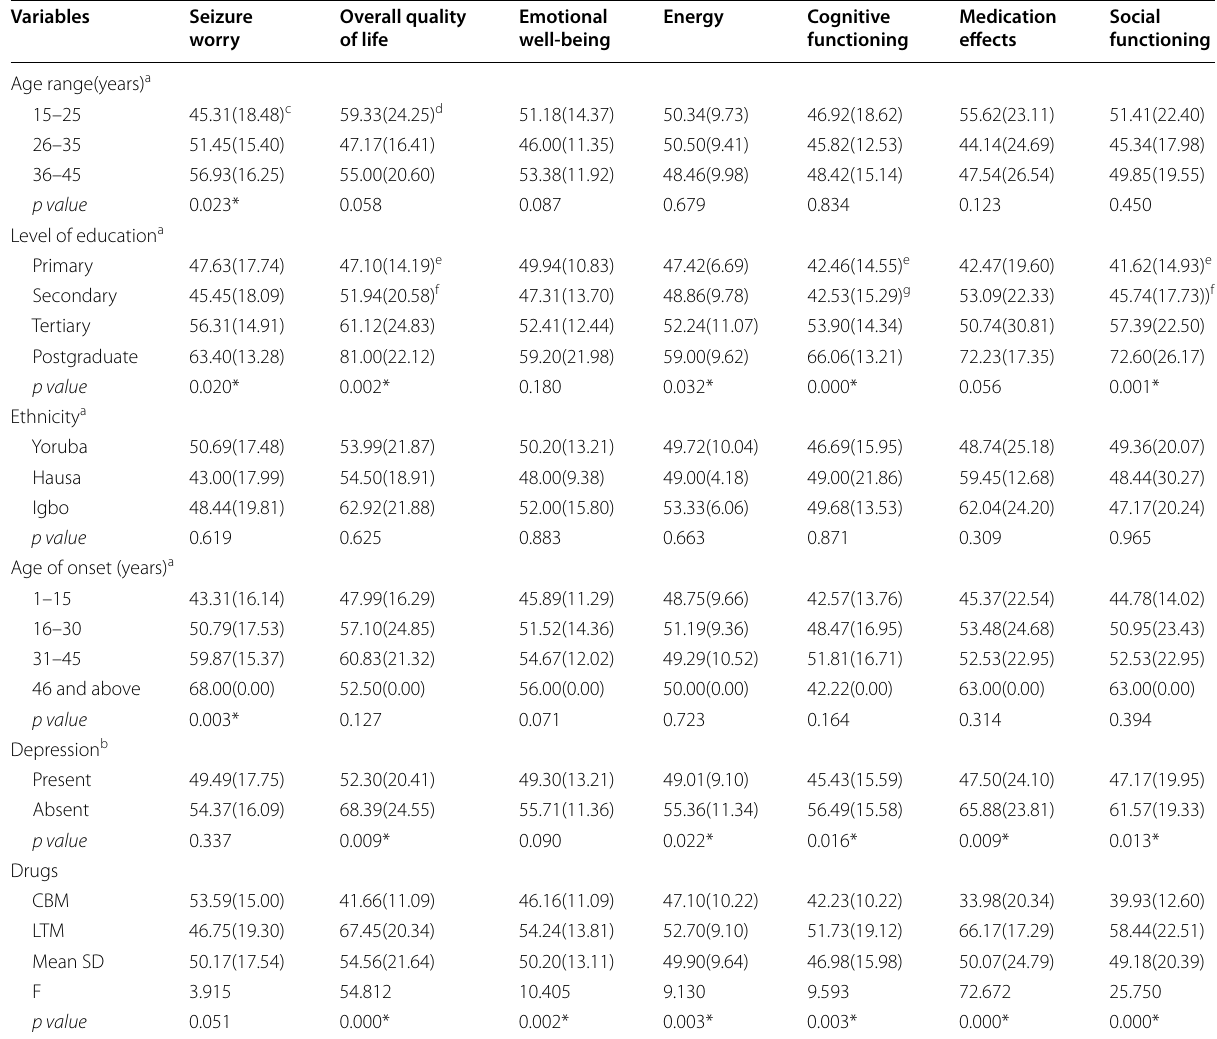
Table 3 Relationship between socio‑demographic characteristics and QOLIE‑31